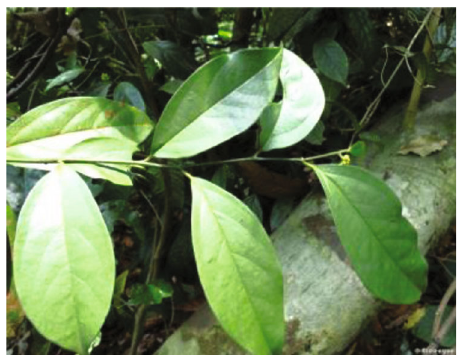
Figure 4: Gomphandra quadri fi da (Blume) Sleumer.